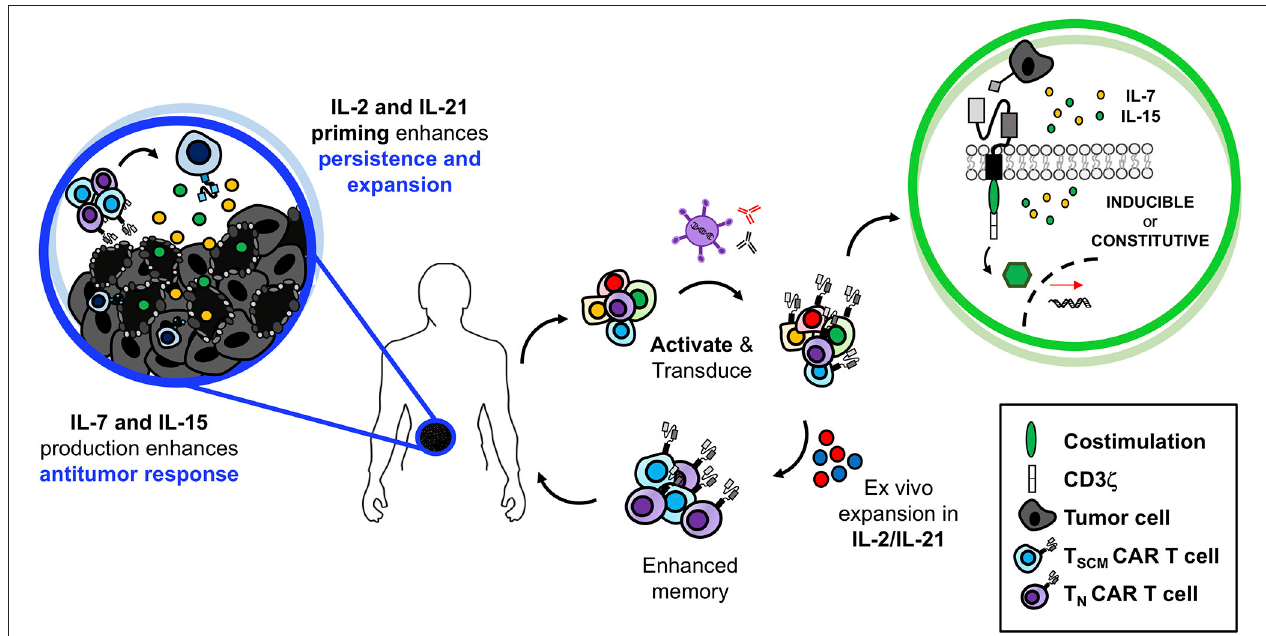
FIGURE 3 | Superior antitumor immunity of IL-2/IL-21-primed CAR T cells producing IL-7 and IL-15 at the tumor site. Generating TRUCKs ex vivo in the presence of IL-2 and IL-21 would prevent terminal differentiation, promote enhanced antitumor immunity with robust T cell proliferation. While at the tumor site, secretion of IL-7 and IL-15 would maintain TRUCK proliferation and memory function allowing for robust and persistent antitumor immunity against solid tumors.